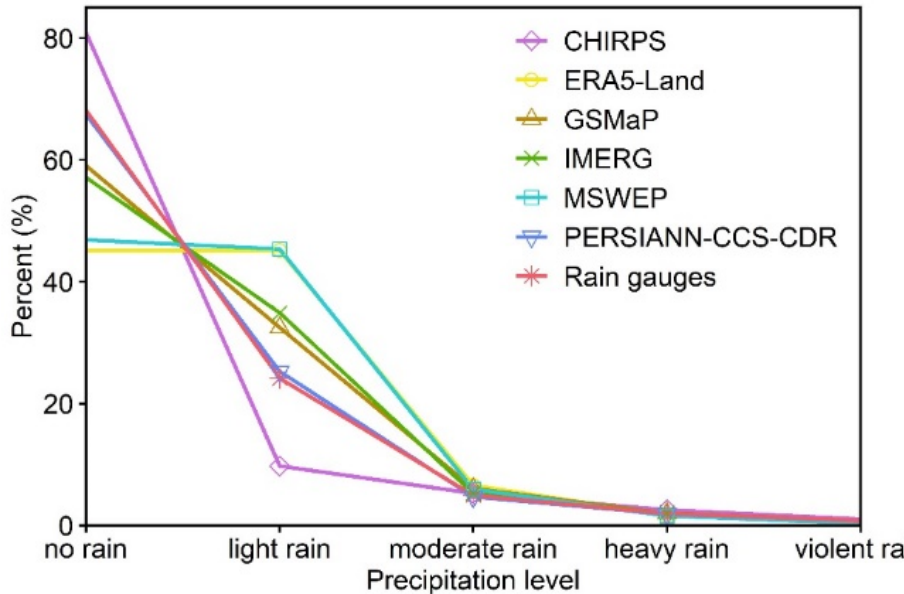
Figure 2. Probability density function of the daily precipitation rate of rain gauges and six precipita- tion products between 2015 and 2019.